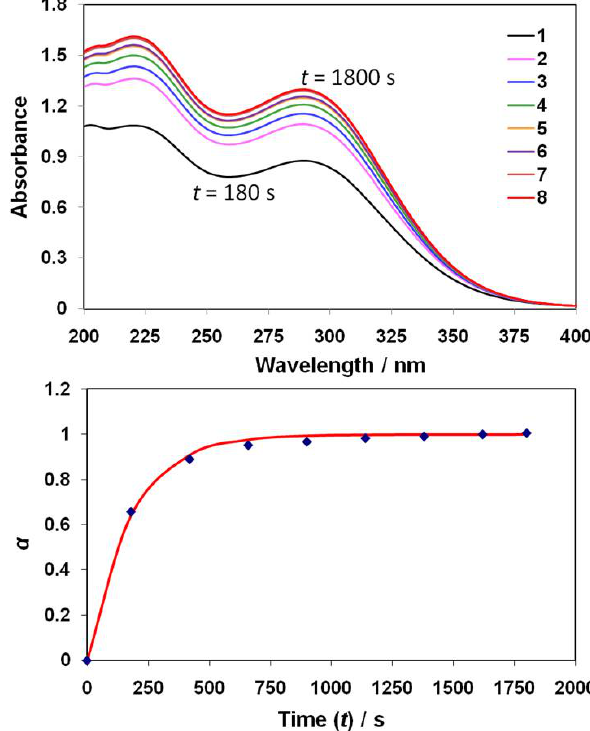
Fig. 2. The top panel shows a time series of UV-visible spectra taken from a 75%Wt H 2 SO 4 solution at 273K, to which amorphous fay- alite powder had been added. The time at which each numbered (consecutive) spectrum was taken is indicated in the bottom panel, which is a plot of the ratio ( α) of measured absorbance at the 289nm (Fe[SO 4 ] − ) peak to the maximum (final) absorbance at time 2